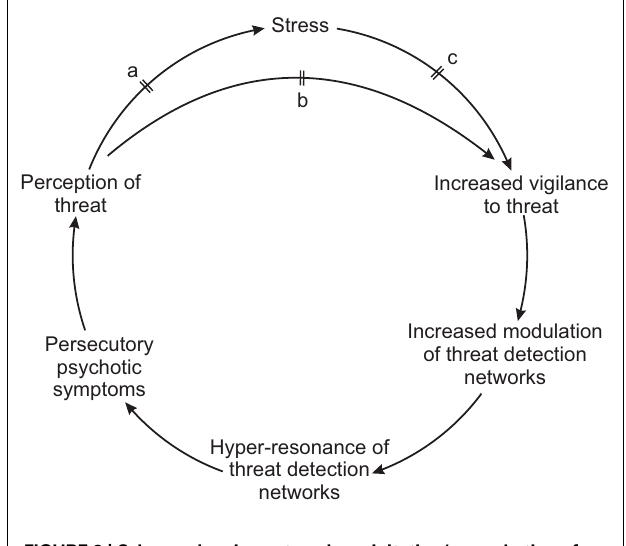
FIGURE 2 | Schema showing external precipitation/exacerbation of psychosis in schizophrenia, maintenance of psychosis, and hypothetical mechanism of action of antipsychotics at points a, b, and